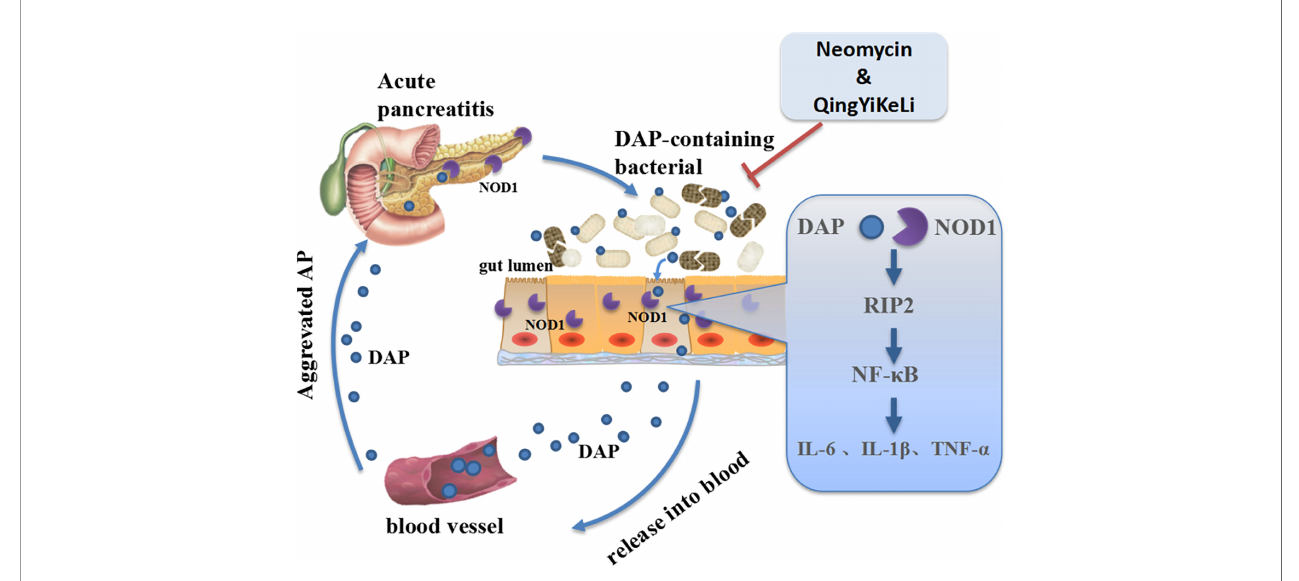
FIGURE 6 | Schematic illustration showing that QYKL and neomycin ameliorate severe acute pancreatitis through the gut microbiota-DAP/NOD1 signaling